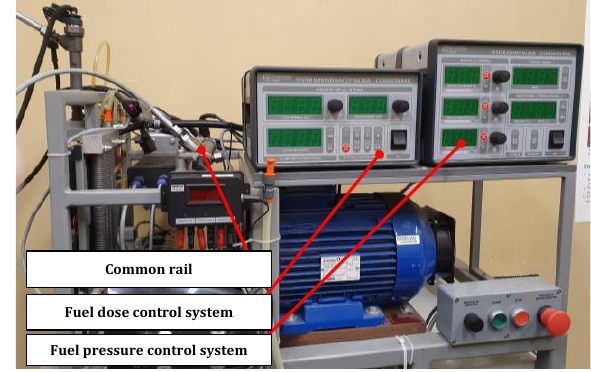
Figure 5. Common rail system by Mechatronika.